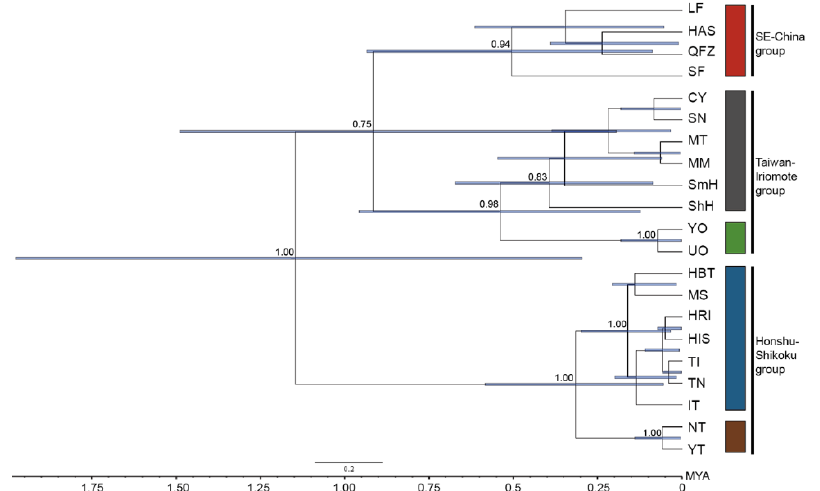
Figure 4. Phylogeny of sampled C. ramondioides populations reconstructed by *BEAST2. The phylo- genetic tree was reconstructed from the 3nrDNA dataset. Numbers above nodes represent posterior probability. Colored squares represent the geographic region.